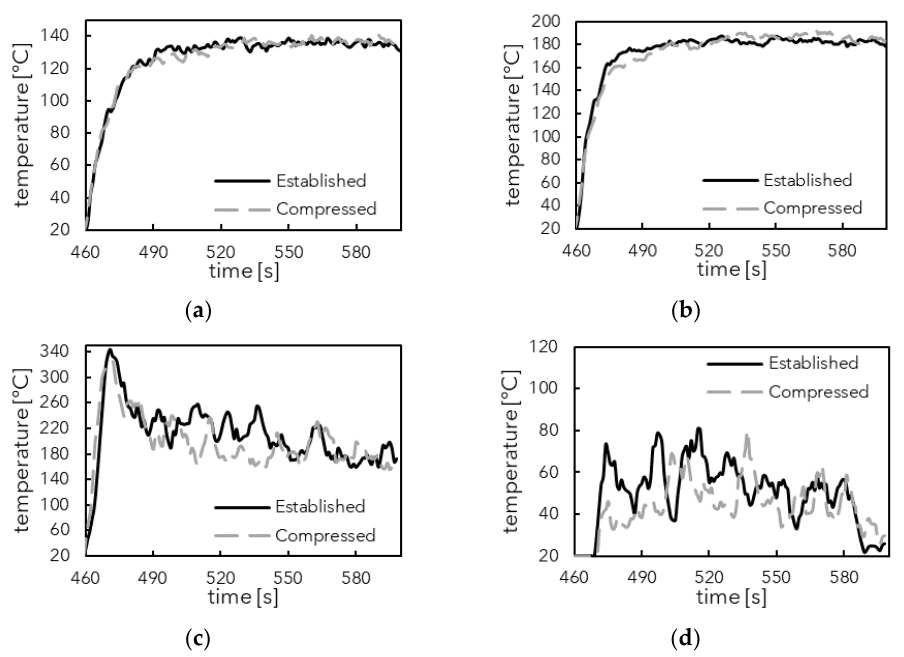
Figure 11. Additional results for the firefighting phase: ( a ) spatially-averaged temperature 1.5 m from floor level; ( b ) spatially-averaged temperature 2 m from floor level; ( c ) temperature at the apartment door 1.5 m from floor level (5 s moving average); ( d ) temperature at the stair door 1.5 m from floor level (5 s moving average).